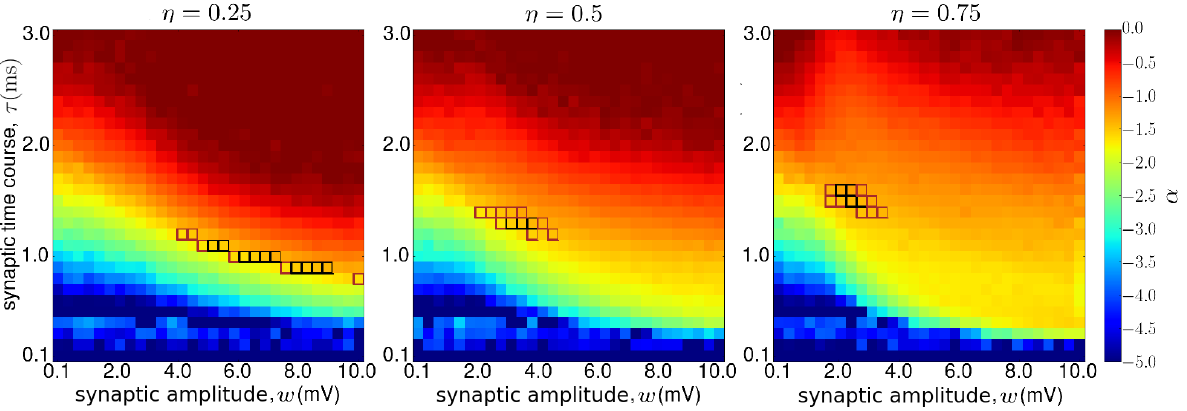
Figure 3. Heatmaps of power-law α exponents. Three excitation populations are considered: ( left ) η = 0.25, ( middle ) η = 0.5 and ( right ) η = 0.75. Black grids correspond to critical exponents, − 1.35 < α < − 1.65, that satisfy p -value > 0.1. Brown grids correspond to 0.005 < p -value < 0.1 that indicate near to critical